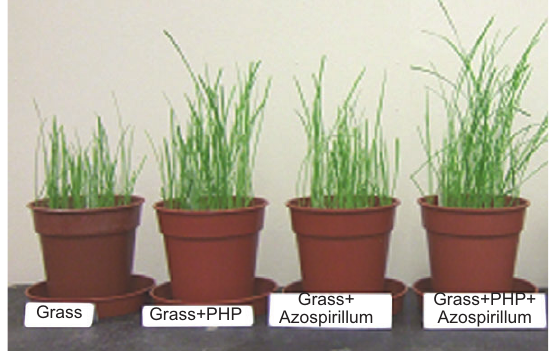
Figure 3 Appearance of grass yield after 12 weeks under different soil treatment. Treatment 1, grass only; treatment 2, grass + PHP; treatment 3, grass + Azospirillum brasilense ; treatment 4, grass + PHP with A. brasilense .